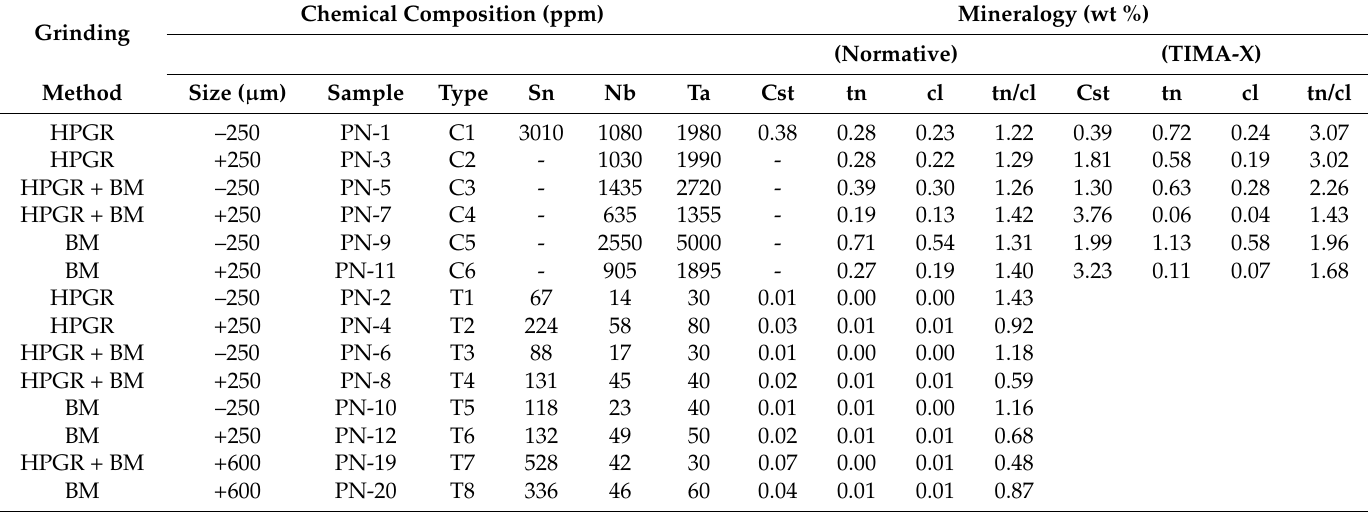
Table 4. Chemical composition and mineralogy of the grinding products of the Penouta ore. tn, tantalite; cl, columbite, and Cst, cassiterite.